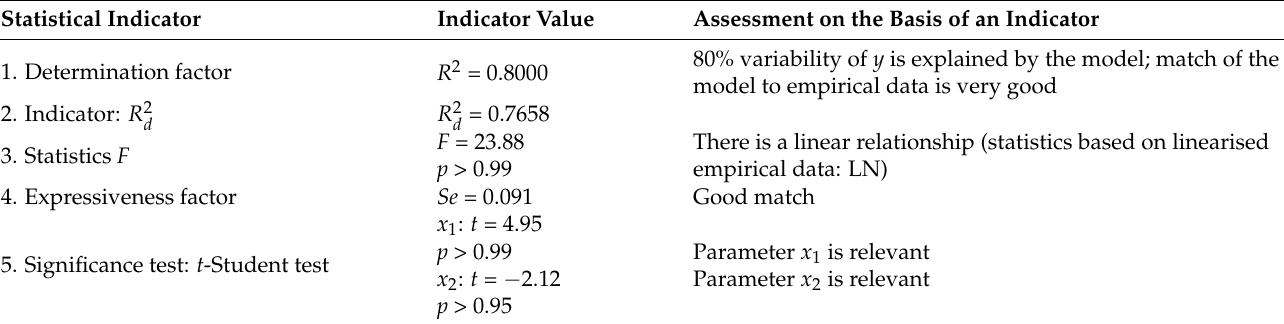
Table 3. Basic statistical analysis of the model no. 2.